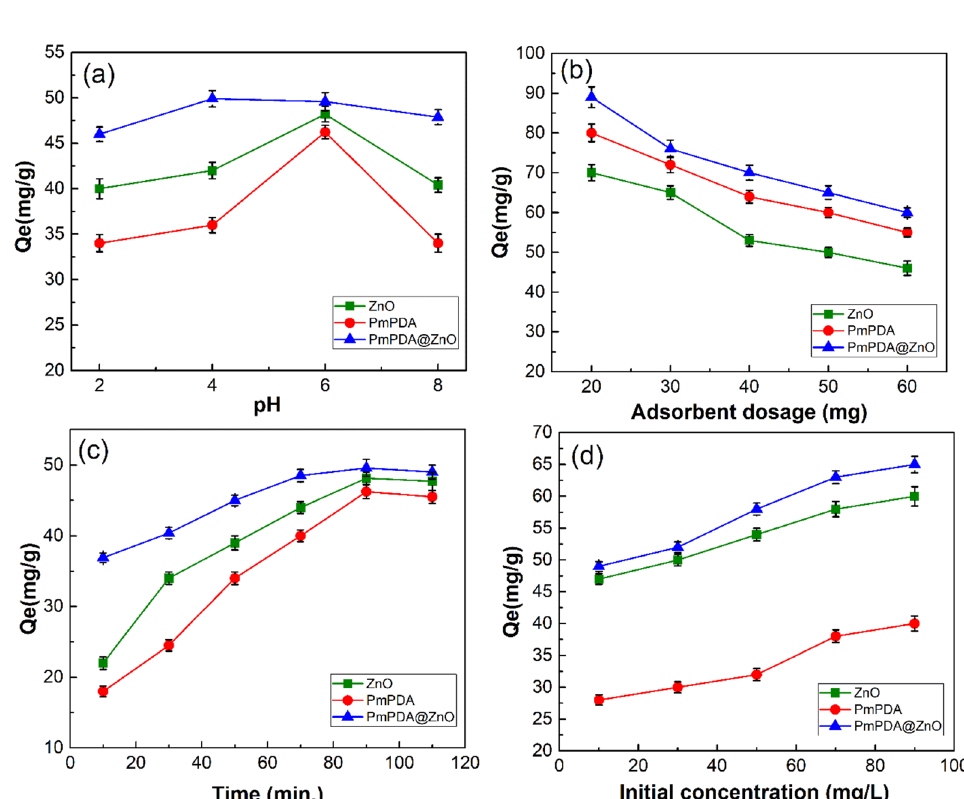
Figure 4. Effect of solution pH (2.0–8.0), T(298 K), adsorbent dosage (50 mg), initial concentration (50 mg/L), V (50 mL) and Time (60 min) ( a ); adsorbent dosage (20–60 mg), pH (6), T (298 K), Time (60 min),